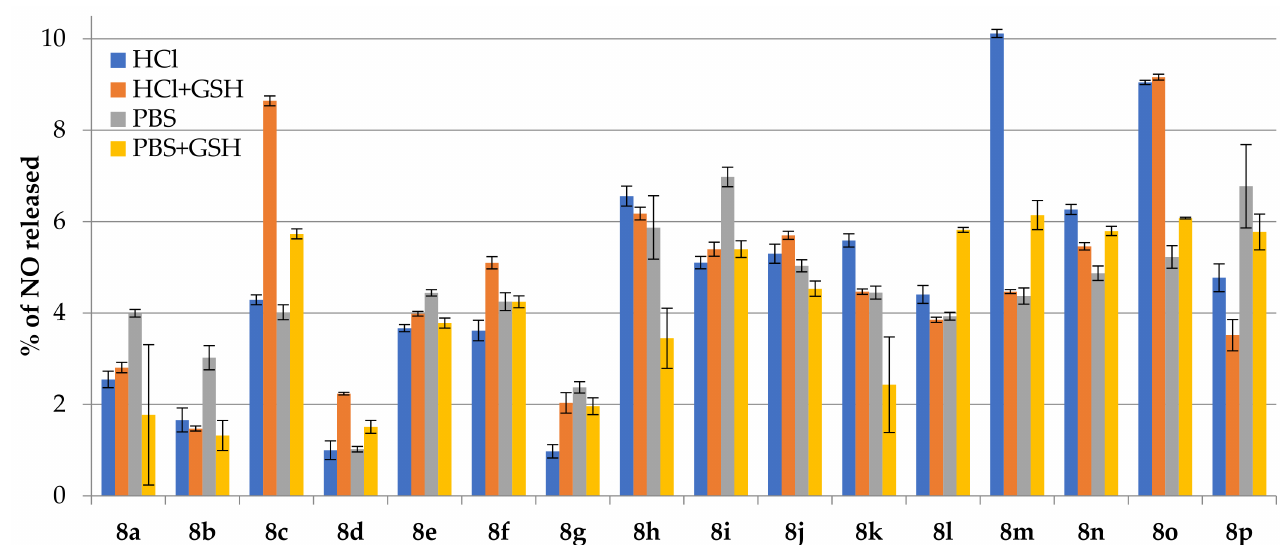
Figure 6. The percentage (%) of NO released by NO-IND-OXDs 8a–p in different experimental conditions (PBS, PBS-GSH,